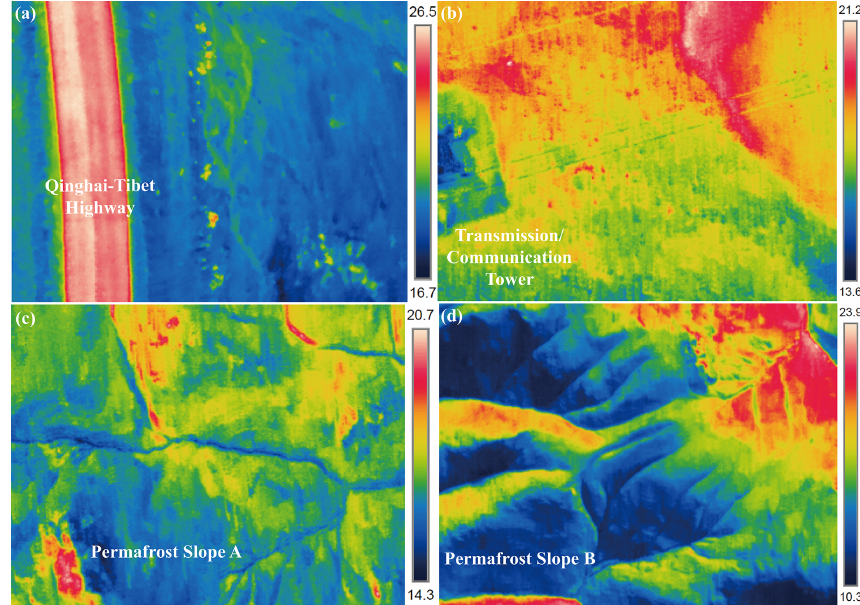
Figure 10. Ground surface temperature using UAVs with TIR sensors: (a) Qinghai–Tibet Highway, (b) power and communication tower, (c) slope A, and (d) slope